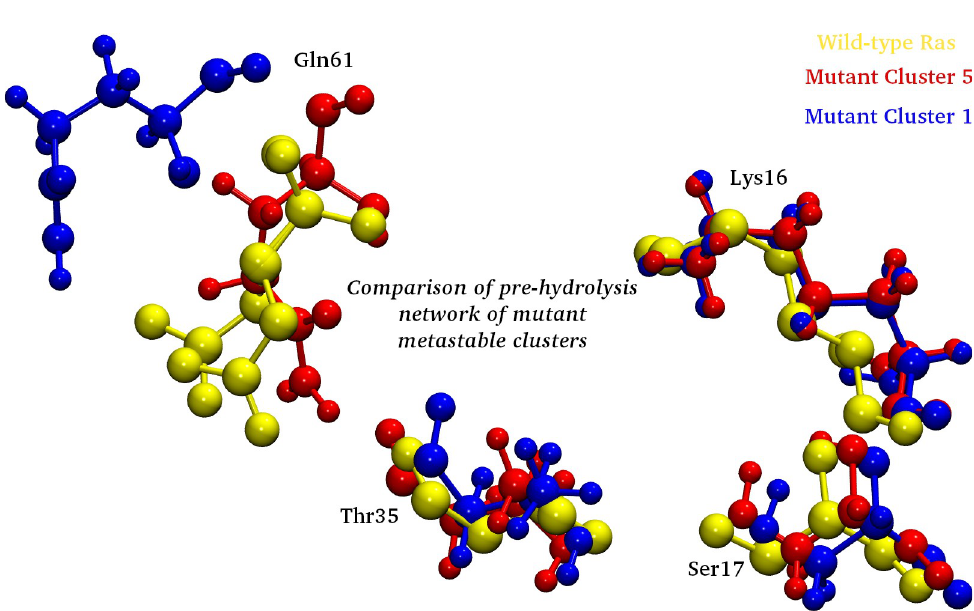
Fig 12. Fig showing the overlap of representative structures of the cluster 5 (mutant), cluster 1 (wild-type and mutant), from the respective MSM based analysis. Yellow CPK representation shows the mutant conformation from cluster 5 (sparsely populated) and the most probable conformations of wild-type and mutant trajectories, from the respective cluster 1.